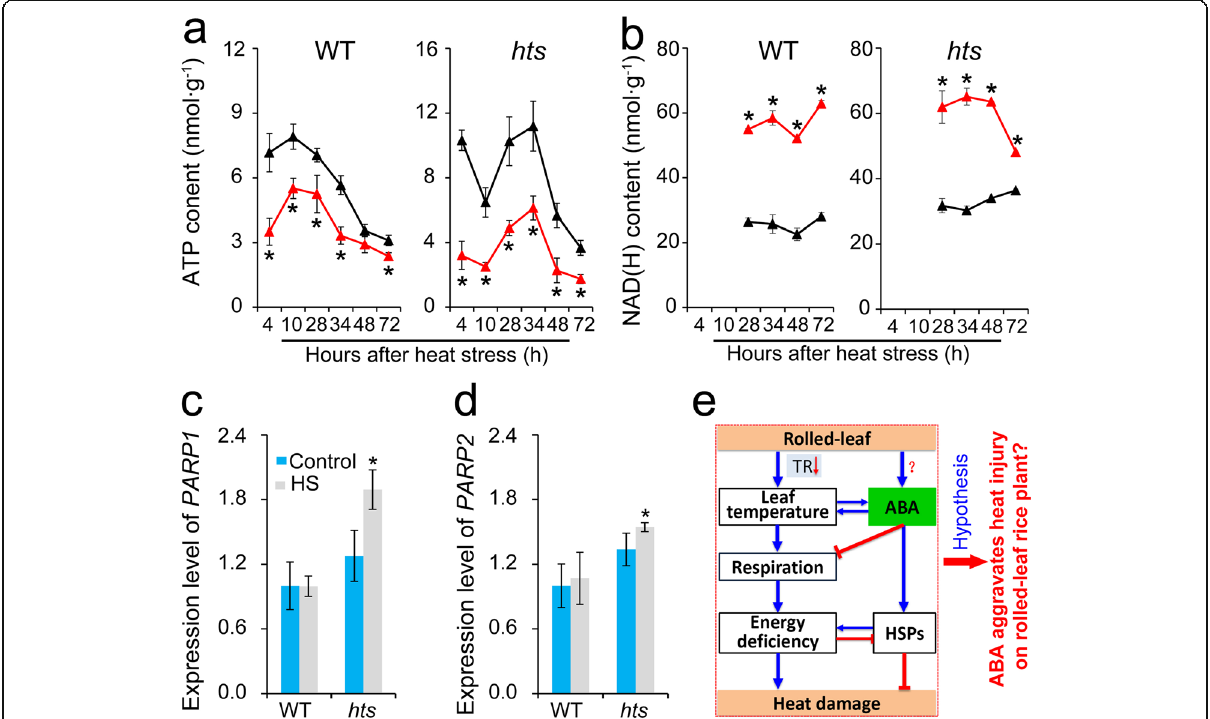
Fig. 5 Effect of heat stress on energy homeostasis in leaves of rice plants. a , ATP content ; b , NAD (H) content; c , Relative expression level of PARP1 ; d , Relative expression level of PARP2 ; e , The possible function of ABA in rice plants with semi-rolled leaves under heat stress. Significantly higher tissue temperatures occurred in the rolled leaf rice plants ( hts ) under heat stress, which was mainly ascribed to lower heat dissipation ability. At the same time, ABA content increased in the rolled leaf plants, which, in turn, increased leaf temperature by reducing the stomatal conductance and transpiration rates. Such an effect could increase the respiration rate of leaves. Therefore, more carbohydrates were consumed, resulting in an energy deficit under heat stress, which caused damage to the rice plants with rolled leaves. Therefore, we inferred that higher ABA content accelerated heat injury in rice plants with rolled leaves. Vertical bars denote standard deviations ( n = 3). A t -test was conducted to compare the difference between the control and heat stressed groups within a cultivar on the same day. * denotes P <